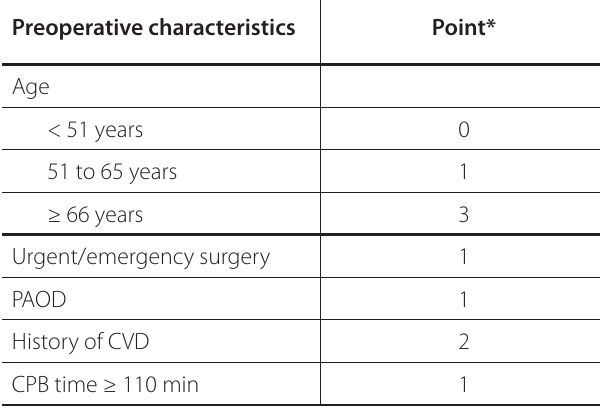
Table 3 . Multivariate risk score calculated using the entire sample (n=4,862).